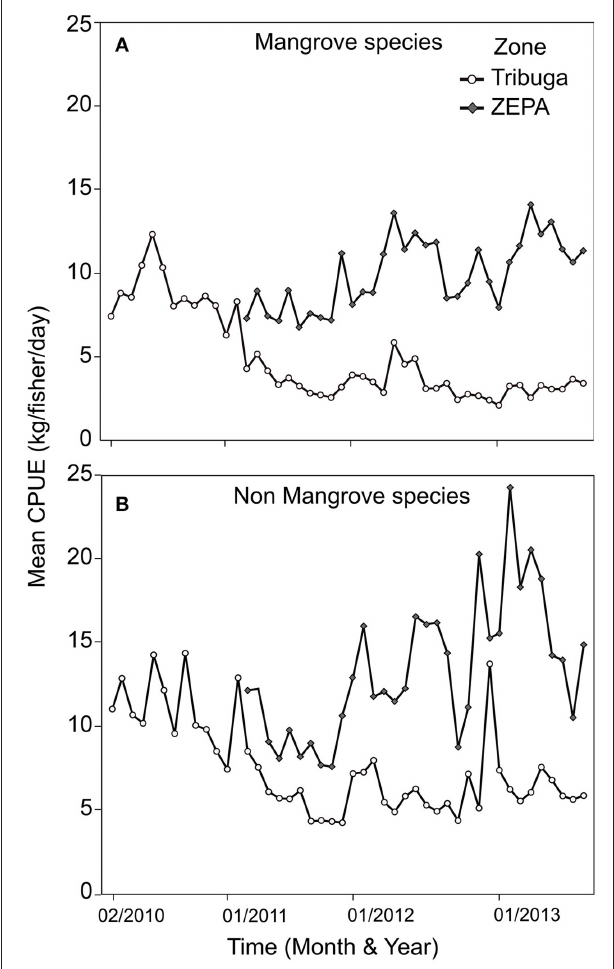
FIGURE 3 | (A) Mean distance from fishing grounds to the coast for the Exclusive Zone of Artisanal Fishing (ZEPA) and the Gulf of Tribugá, and (B) proximity of fishing grounds to the coast in relation to boat engine size in Northern Chocó region between 2010 and 2013. Error bars represent the SE of the mean.